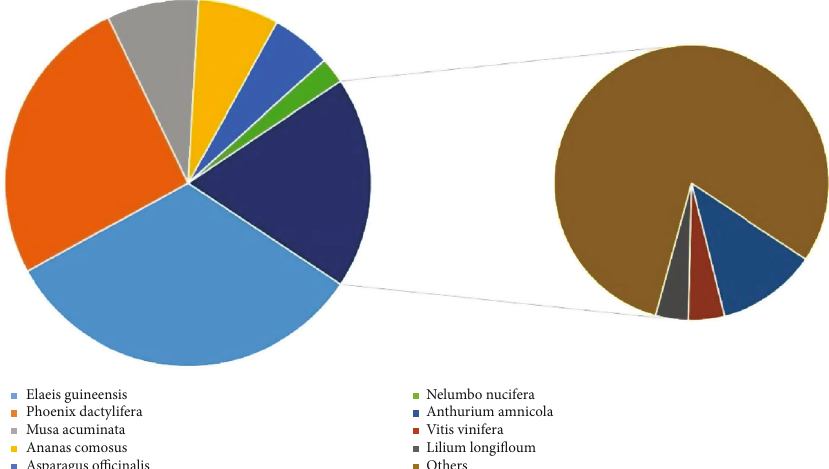
Figure 3: Prediction of lncRNAs using CNCI, CPC, CPAT, and Pfam analysis tools, as indicated in the Venn